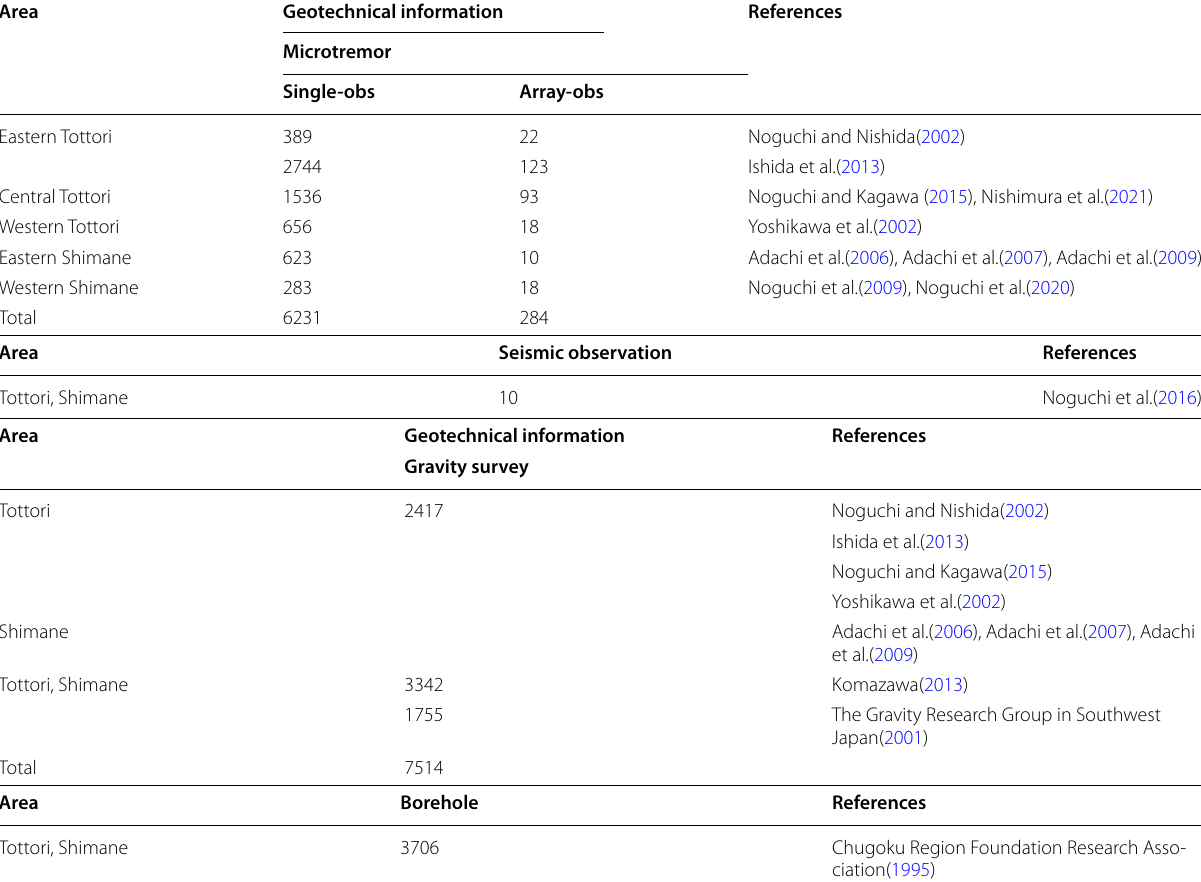
Table 1 Contents of the geotechnical information database and number of observation points for each reference and observation